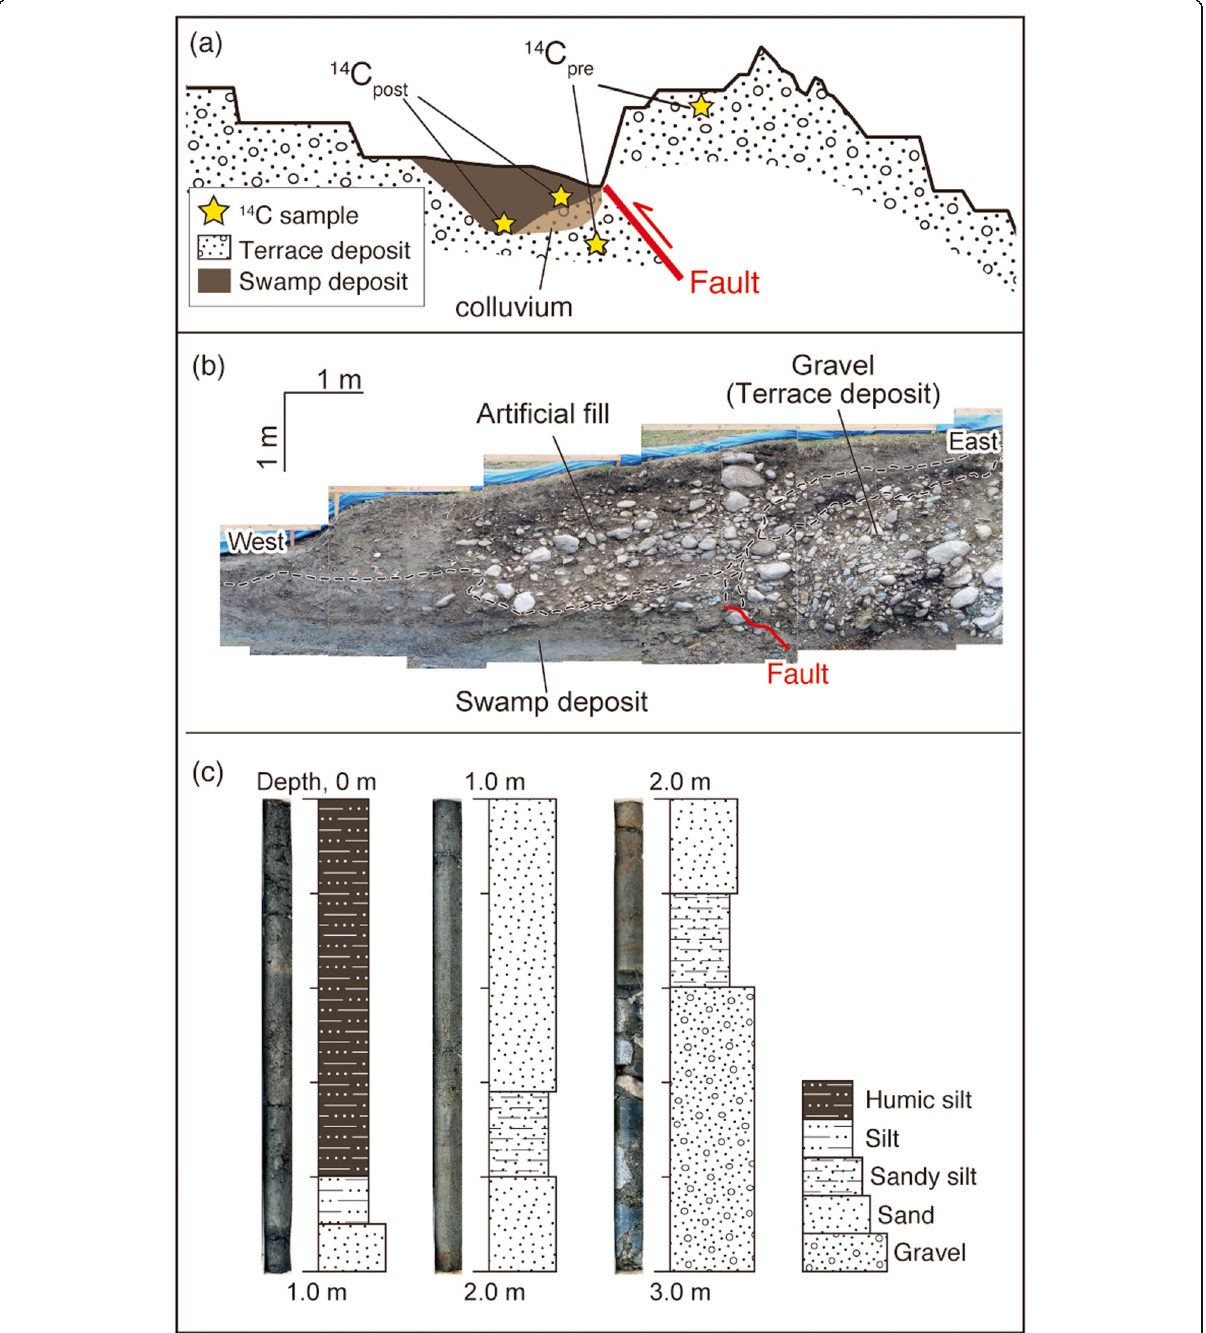
Fig. 4 Typical stratigraphy along an uphill-facing scarp. a Schematic illustration to explain our strategy for determining terrace age. The age for each terrace is bracketed by a 14 C age from the swamp deposit and that from terrace-forming deposit. b An exposure of paleoseismic trench by Toda et al. (2016) at Oide. Both Loc. 4 and Loc. 5 are located within this trench. c A drilled core obtained at Loc. 4. Swamp deposit continues from the surface to the depth of 2.4 m and covers a gravel layer that corresponds to that shown in